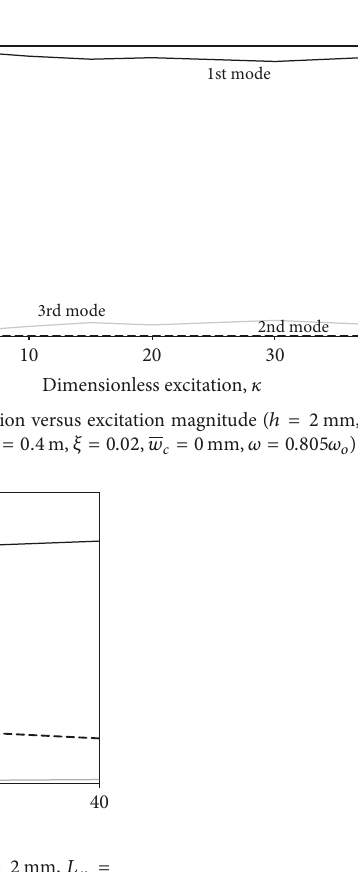
(c) Modal contribution versus excitation magnitude ( ℎ = 2 mm, 𝐿 𝑥 = 0.5 m, 𝐿 𝑧 = 0.3 m, 𝐵 = 0.4 m, 𝜉 = 0.02 , 𝑤 𝑐 = 2.5 mm, 𝜔 = 3.22𝜔 𝑜